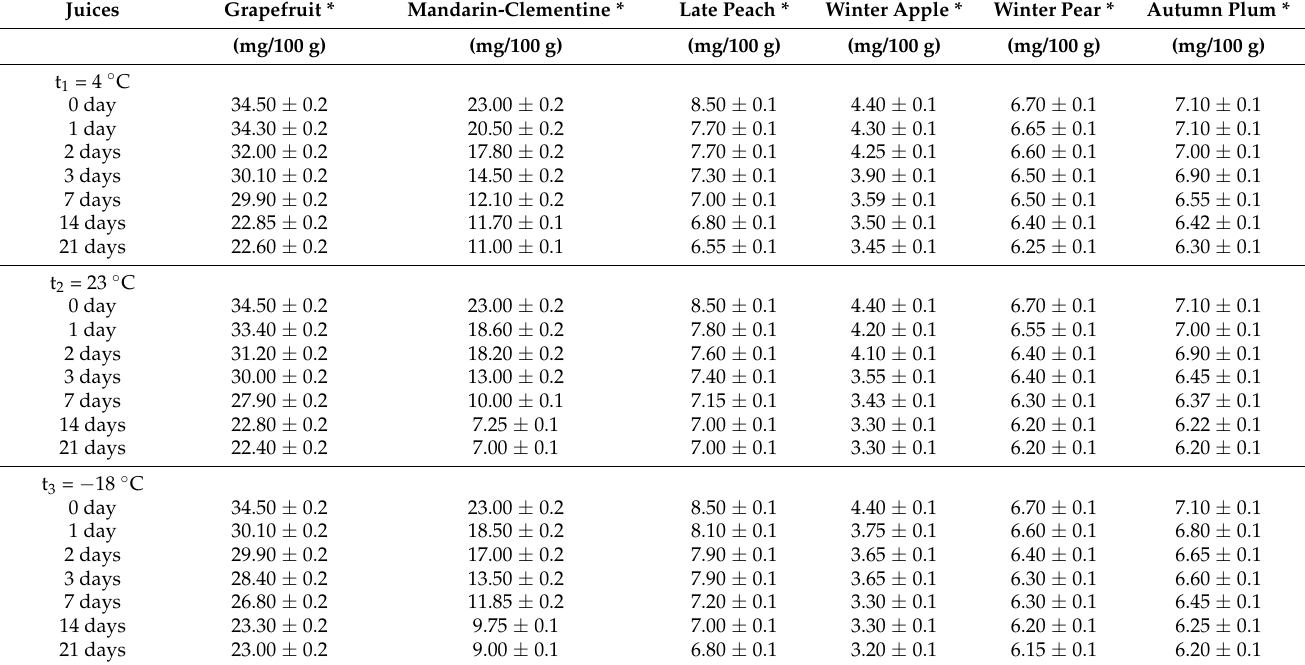
Table 1. The vitamin C content of fruit juices at certain storage temperatures in glass